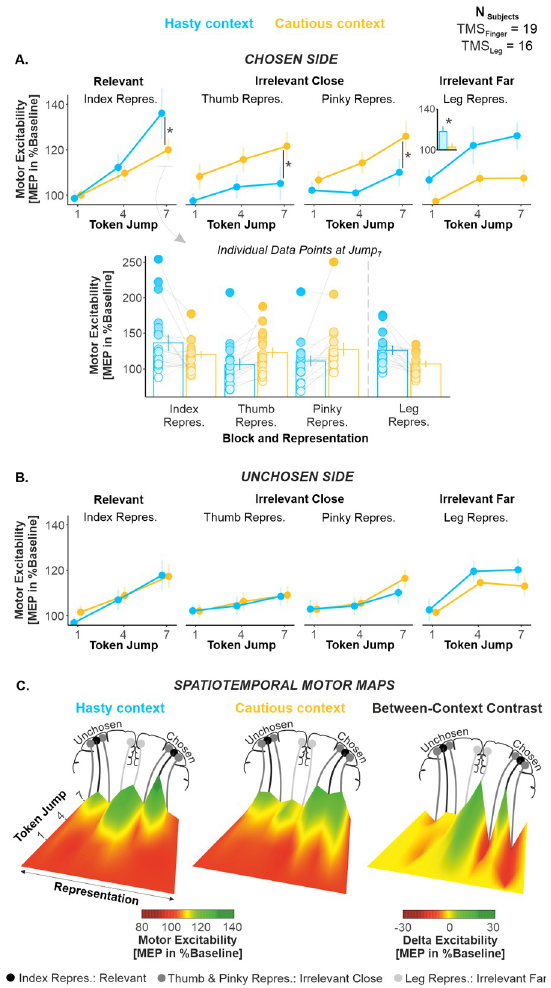
Fig 4. (related to S4–S6 Figs as well as S2 and S3 Tables). Hastiness relied on a broad amplification and a surround suppression of motor excitability on the chosen side. (A) Effect of CONTEXT on motor excitability on the chosen side. The top graphs show excitability changes occurring over the decision period in the hasty and cautious contexts (blue and yellow traces, respectively). Given that the effect of context was reproducible across the 3 leg representations (see S5 Fig), the MEP data have been pooled together (right panel). The inset in the right panel denotes the main effect of context on the leg region. The bar graph at the bottom displays individual data points as obtained at Jump 7 , for each context and each representation. Error bars represent 1 SEM. � : significant effect of context at p < 0.05. (B) Same as A. for the unchosen side. (C) Spatiotemporal motor maps. We computed spatiotemporal maps to provide an integrative view of motor excitability changes occurring during the course of deliberation in each context (see main text). To this aim, we considered altogether the MEPs obtained for the index, thumb, pinky, and leg representations of the chosen and unchosen sides, and we arranged them spatially according to M1 somatotopy. One spatiotemporal map was obtained for each context, and a between-context difference map was finally computed (i.e., hasty minus cautious context). The difference map (right panel) highlights the increase in excitability in the index and leg representations of the chosen side (right side of the map, green, positive values) as well as the surround suppression occurring in the thumb (more lateral) and pinky (more medial) representations (red, negative values). Besides, no noticeable between- context difference emerged on the unchosen side (left side of the map, yellow values). All individual and group- averaged numerical data exploited for Fig 4 are freely available at this link: https://osf.io/tbw7h. M1, primary motor cortex; MEP, motor-evoked potential; TMS, transcranial magnetic